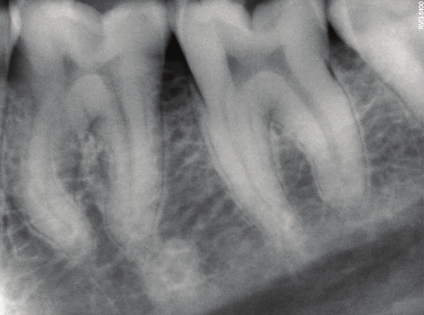
Figure 18: Preoperative RVG: 36, 37.